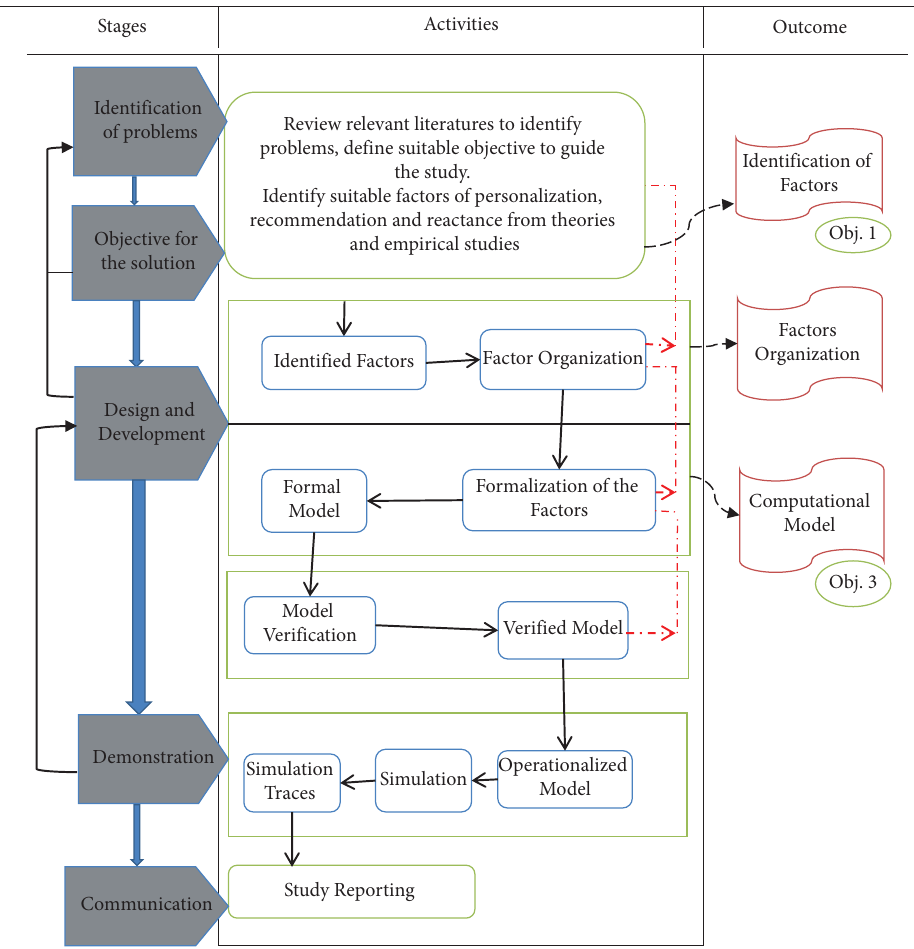
Figure 1: Te research framework.